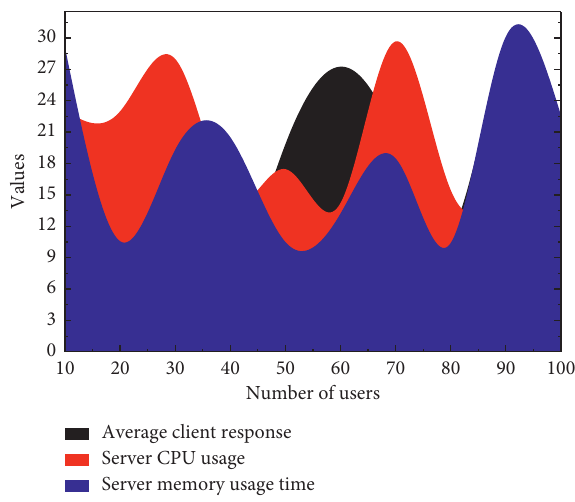
Figure 8: Server performance